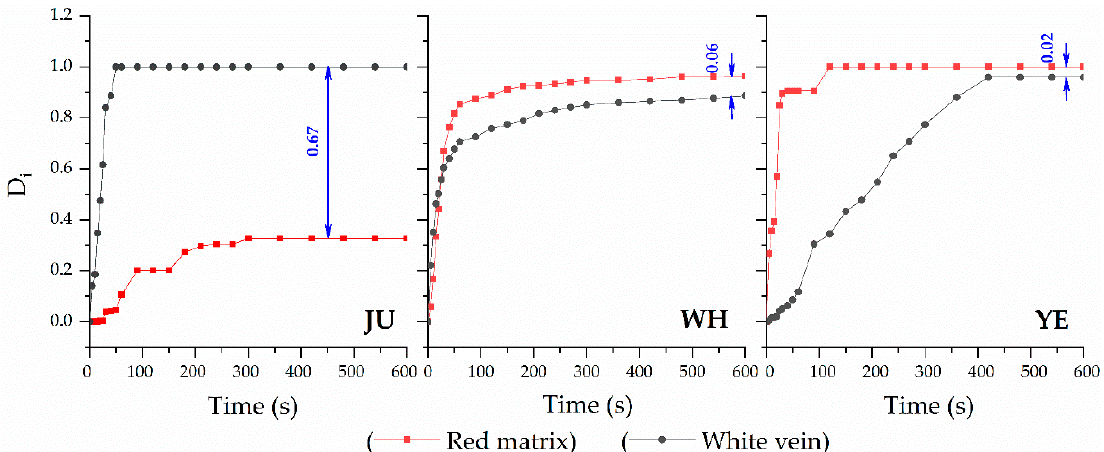
Figure 12. Disintegration index of red matrix and white vein with time.